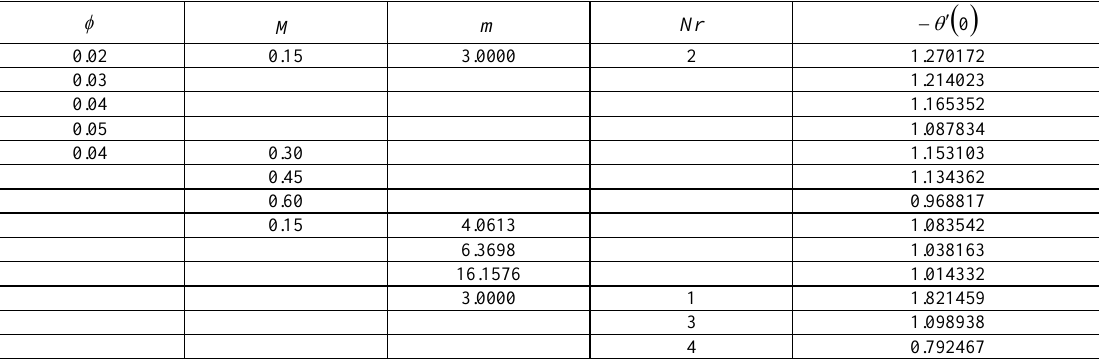
Table 3. Numerical results of  0   for different values of relevant specified parameters when 8 . 6 P r